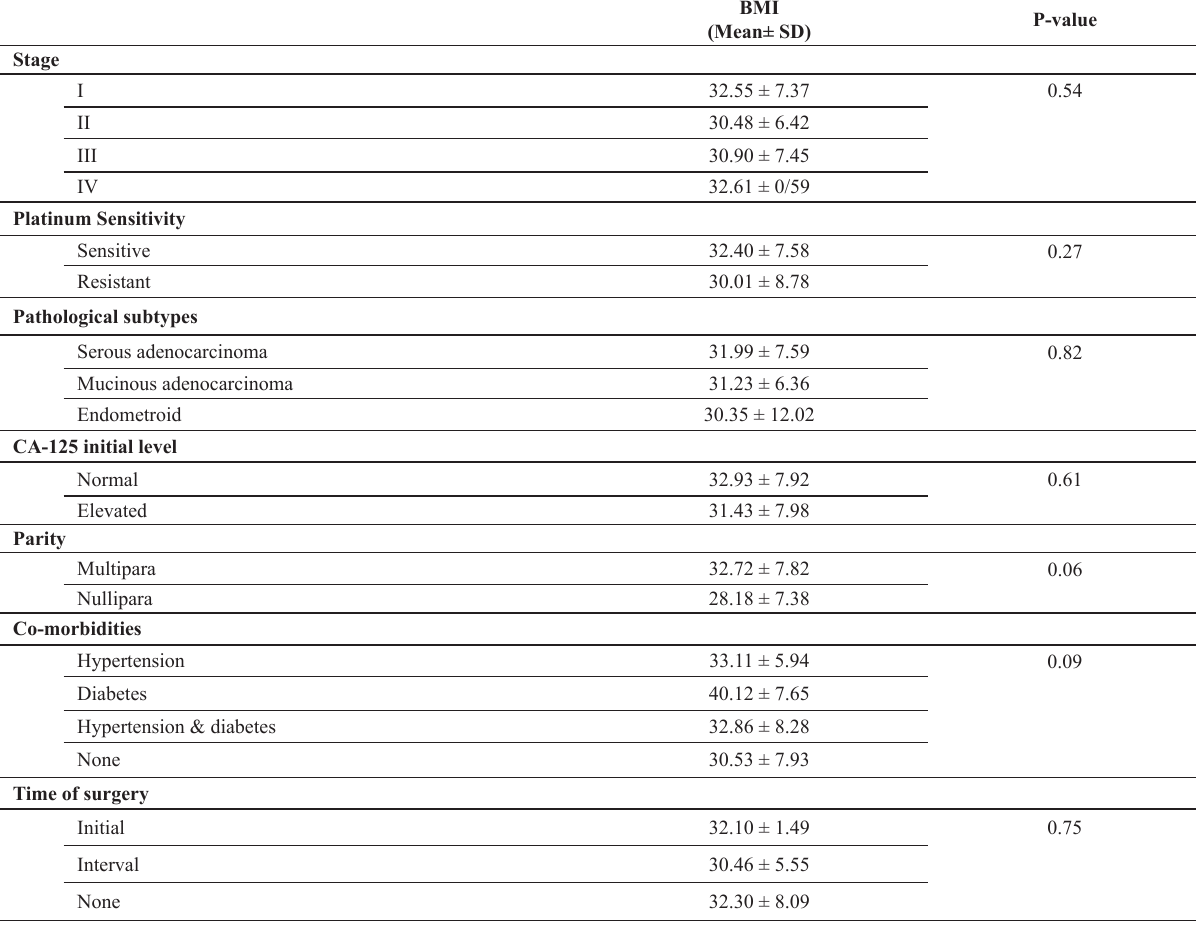
table 4: Comparison between different aspects of characteristics regarding